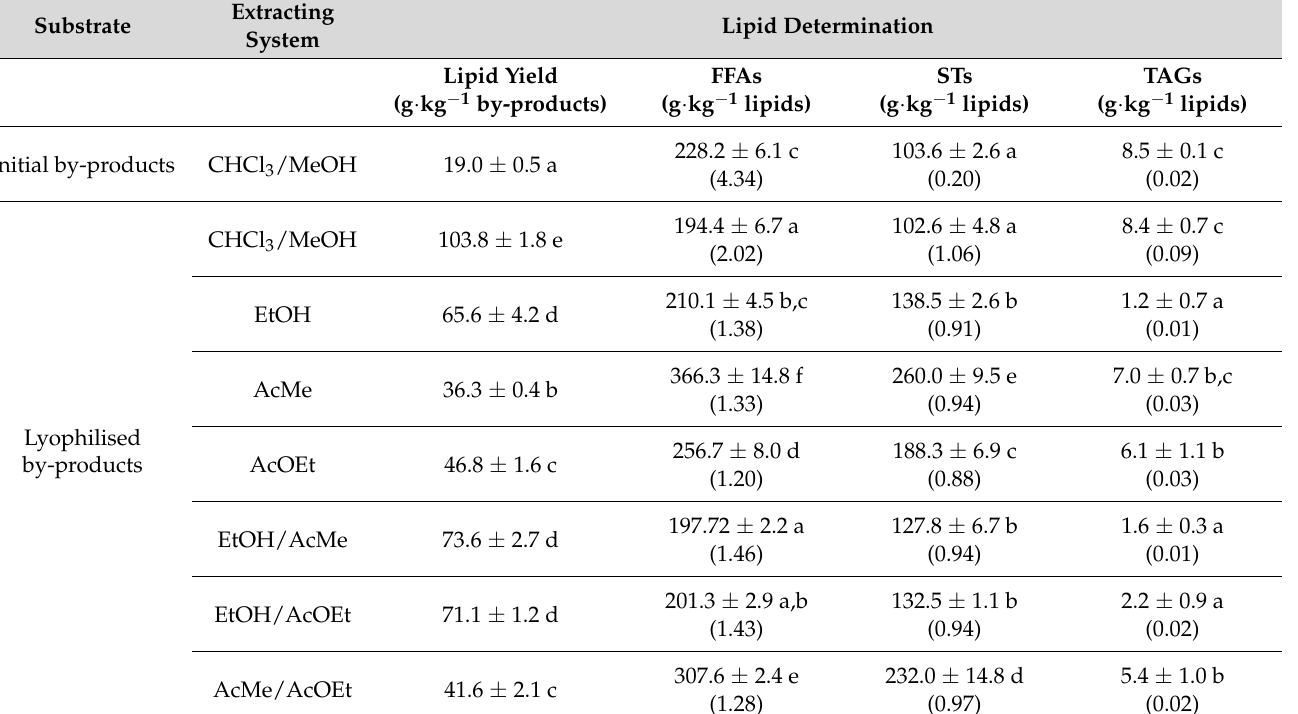
Table 1. Determination * of lipid yield and lipid class content of initial by-products and lyophilised by-products obtained by different lipid-extracting systems